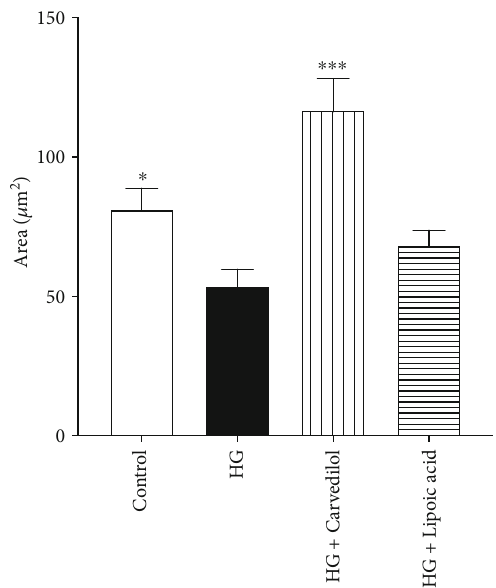
Figure 7: E ff ect of the carvedilol on soma area in high-glucose media.